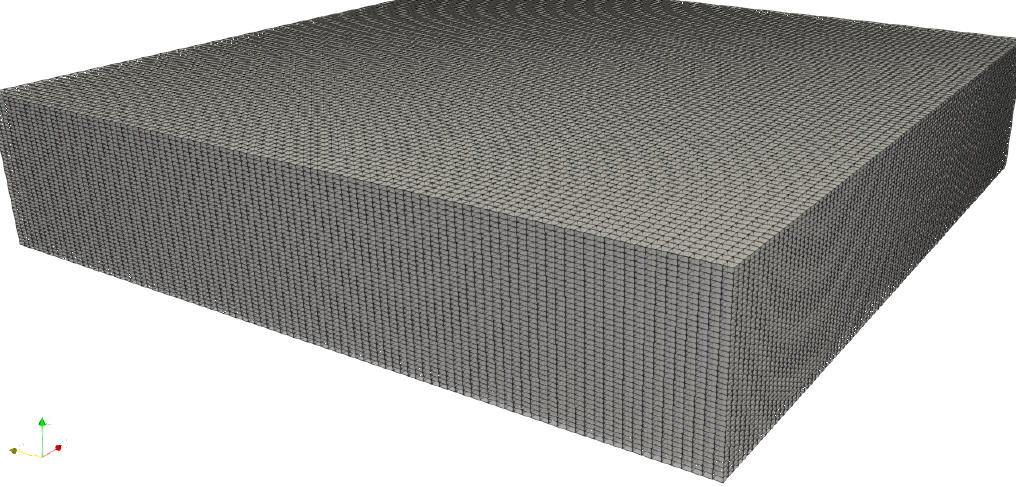
Figure 9. Orthogonal mesh used to compute the reference